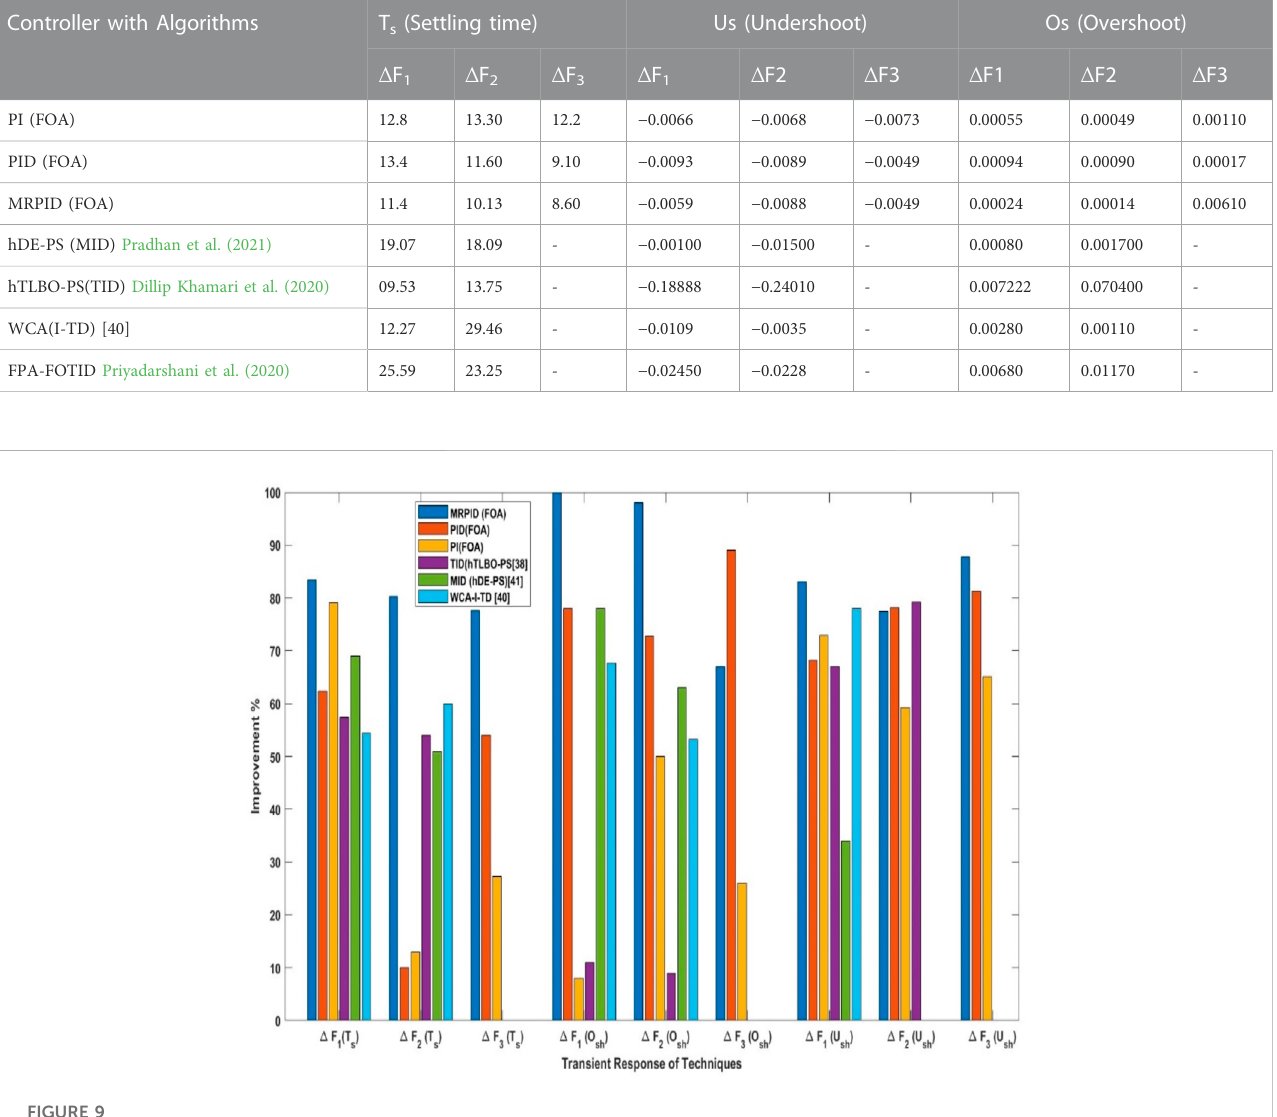
FIGURE 9 Comparison of different techniques for each area in terms of percentage improvement for Ts, Osh and Ush.